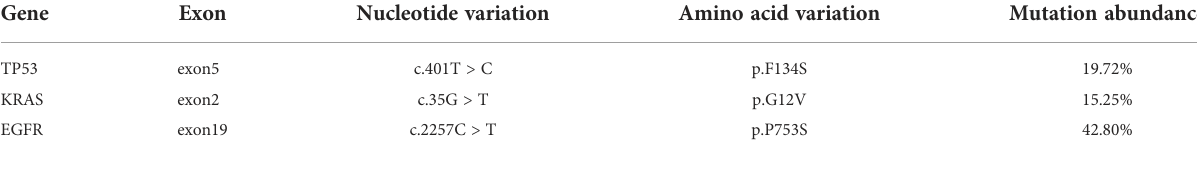
TABLE 1 Gene mutation